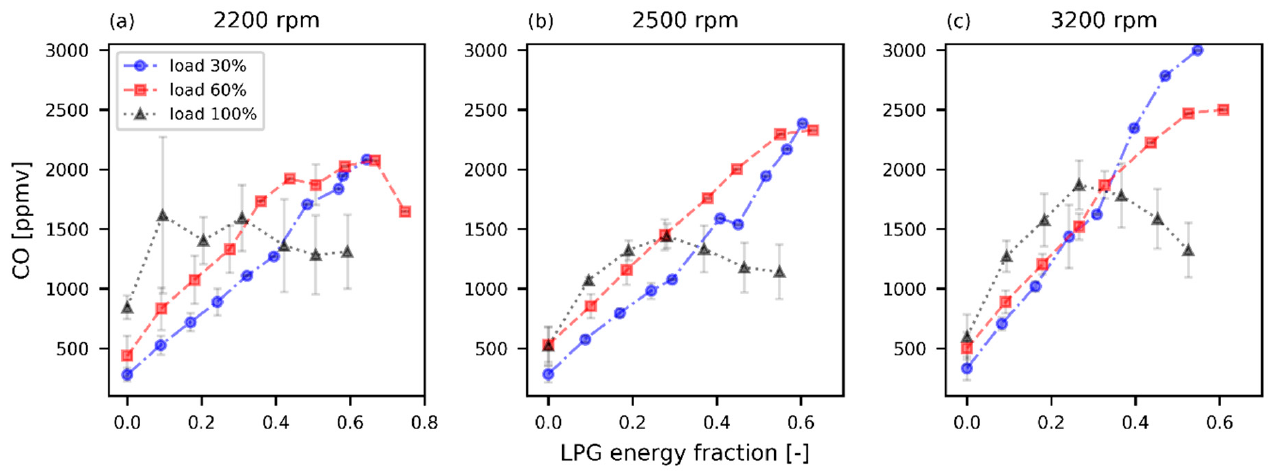
Figure 8. CO emissions v/s LPG energy fraction at ( a ) 2200 rpm, ( b ) 2500 rpm, and ( c ) 3200 rpm.